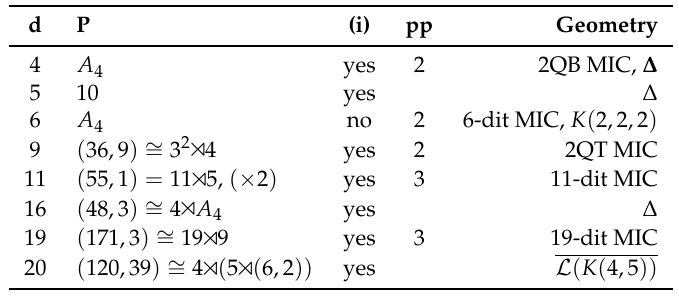
Table 2. Table of 3-manifolds M 3 found from subgroups of finite